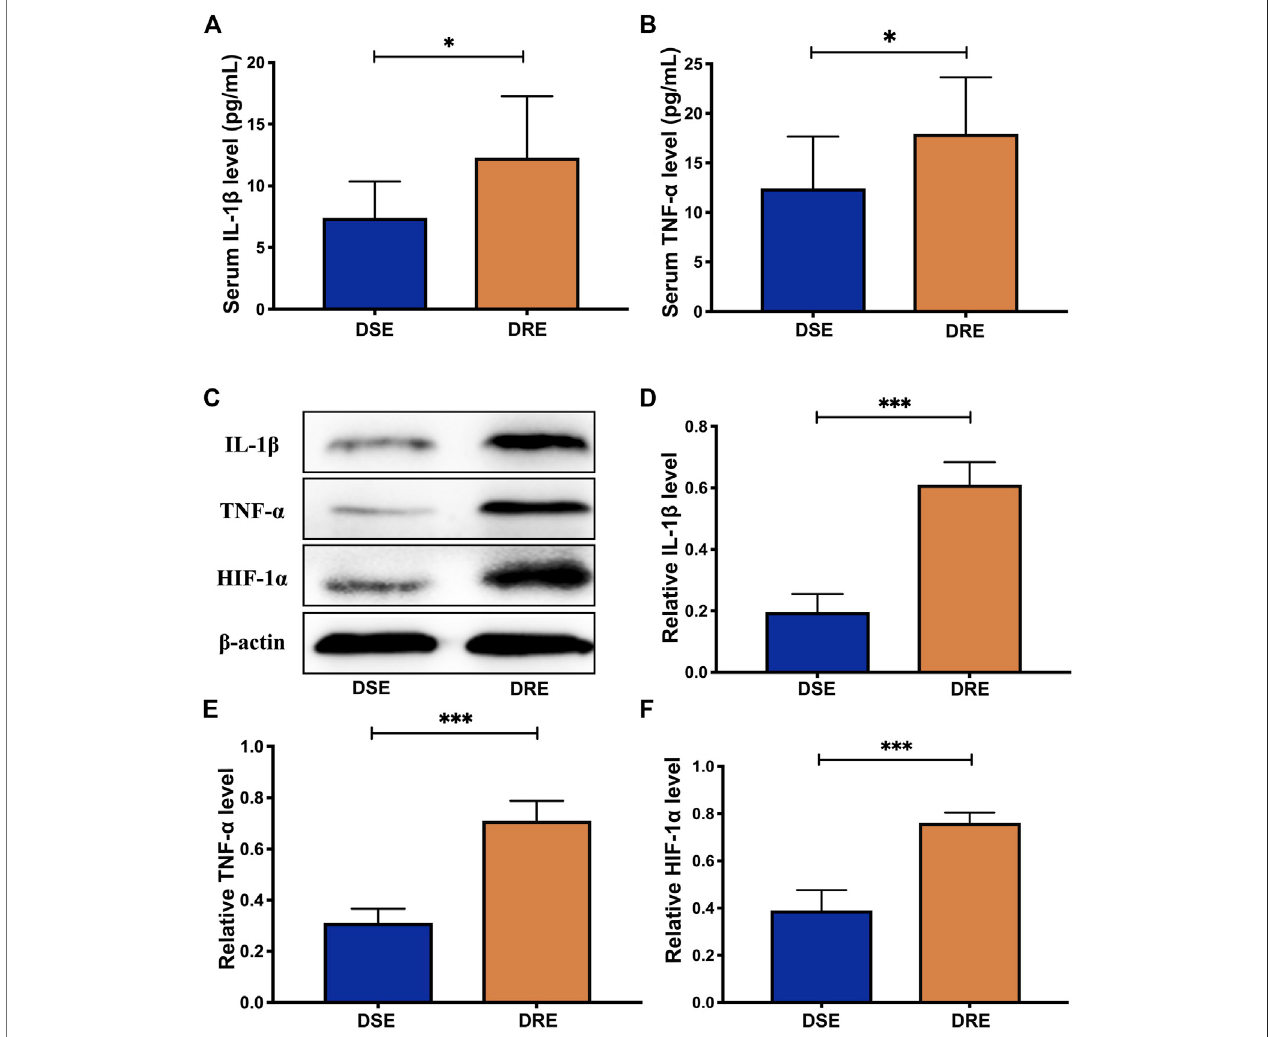
FIGURE4| Validationanalysisofselectedproteins.ThelevelofIL-1 β (A) and TNF- α (B) inthebloodofchildrenwithVPA-resistantepilepsysigni fi cantlyhigherthan that inVPA-sensitiveepilepsy using ELISAanalysis(DSE: n (cid:1) 8;DRE: n (cid:1) 16). (C) Representativeprotein bands ofIL-1 β ,TNF- α and HIF-1 α ofhippocampus determined by western blotting ( n (cid:1) 6). Protein expression of IL-1 β (D) , TNF- α (E) and HIF-1 α (F) in the hippocampus of mice with VPA-resistant epilepsy greatly higher than that of micewithVPA-sensitiveepilepsy( n (cid:1) 6).Valuesarethemean ± S.D.Unpaired t -test.* p < 0.05,** p < 0.01,and*** p < 0.001.DSE:VPA-sensitiveepilepsyandDRE: VPA-resistant